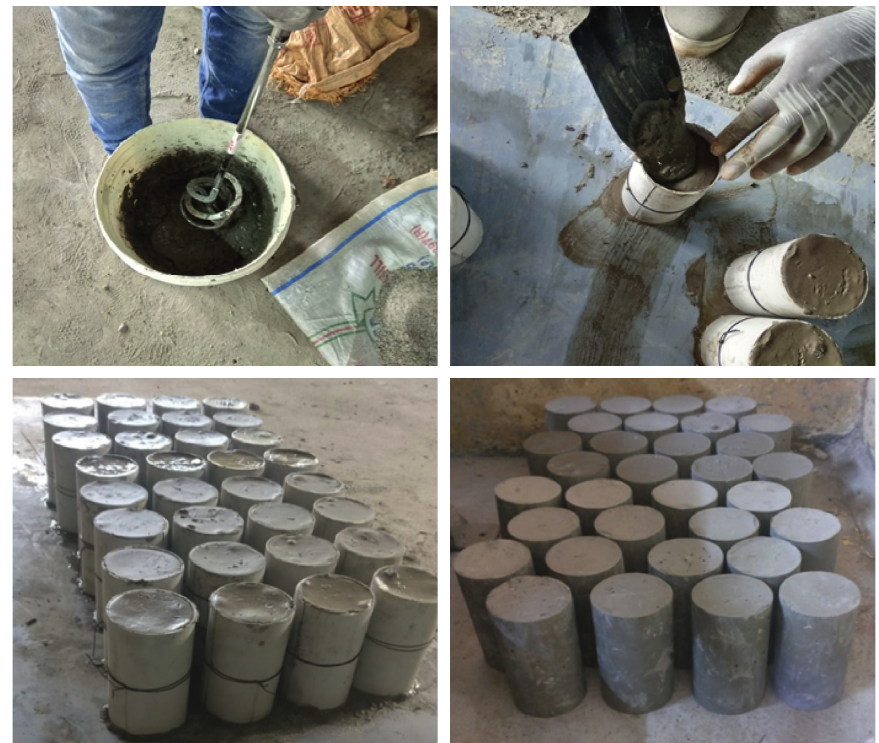
Figure 2: Mixing, casting, cast specimens, and demoulded geopolymer mortar specimens.